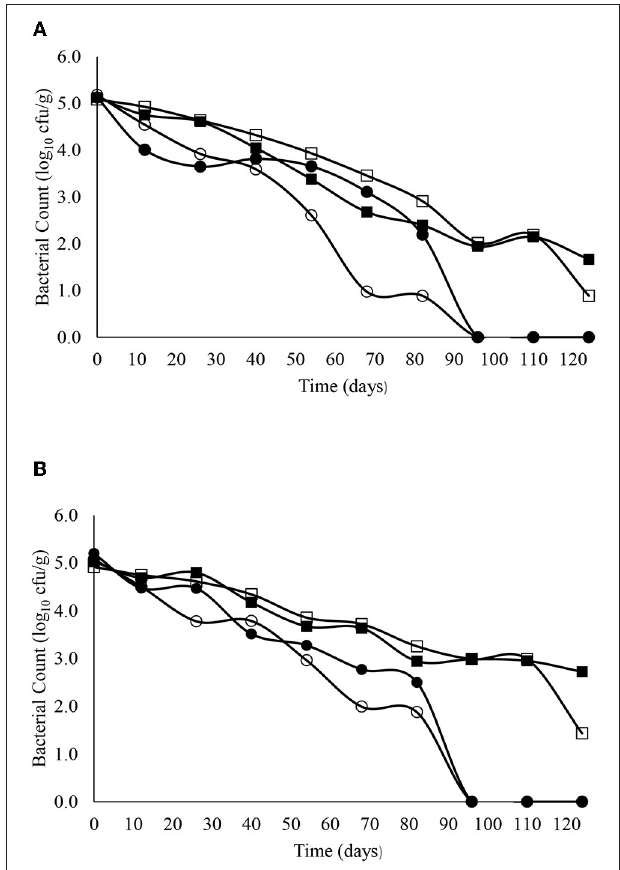
FIGURE 7 | The reduction in C. sporogenes over time in sandy (A) and clay (B) soils including with slurry at 4 ◦ C ( (cid:4) ), digestate at 4 ◦ C ( (cid:3) ), slurry at 14 ◦ C ( • ) and digestate at 14 ◦ C